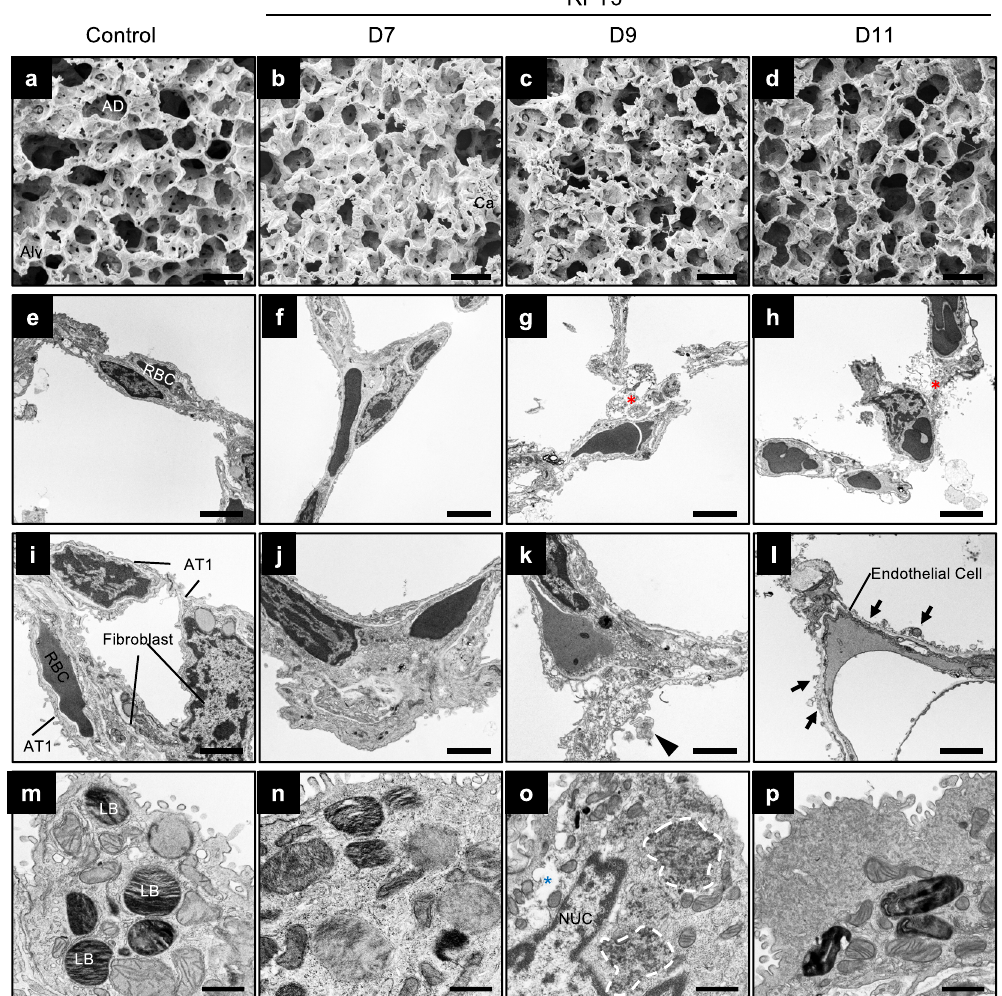
Figure 3. Altered alveolar epithelial structure in RPT3 AT2 Δ / Δ mice. ( a – d ) SEM analyses of alveolar architecture on days 7, 9 and 11 after tamoxifen treatment (days 1–7). AD: alveolar duct, Alv: alveolus and alveolar walls, Ca: capillary. n = 2 mice/genotype. ( e – p ) TEM of alveolar walls. Pronounced membrane blebbing (arrows; l) was observed in AT1 cells. Arrowhead (k) points to cellular debris. Dashed circle ( o ): accumulation of electron dense macromolecules. Red asterisks ( g , h ): disintegrated alveolar walls. Blue asterisk ( o ): vacuole in AT2 cell. LB: lamellar body, NUC: nucleus. Scale bars = 50 μ m ( a – d ), 5 μ m ( e – h ), 2.5 μ m ( i – l ) and 1 μ m (m-p). n = 2–4 mice/genotype. Controls included both Sftpc WT/CreER :RPT3 F/F mice without tamoxifen treatment and Cre mice that were fed tamoxifen chow for 7